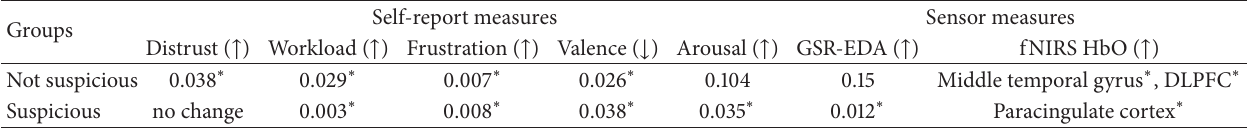
Table 2: 𝑃 values for 𝑡 -tests comparing the effects of the day 2 versus day 3 manipulations on the dependent variables in the study.